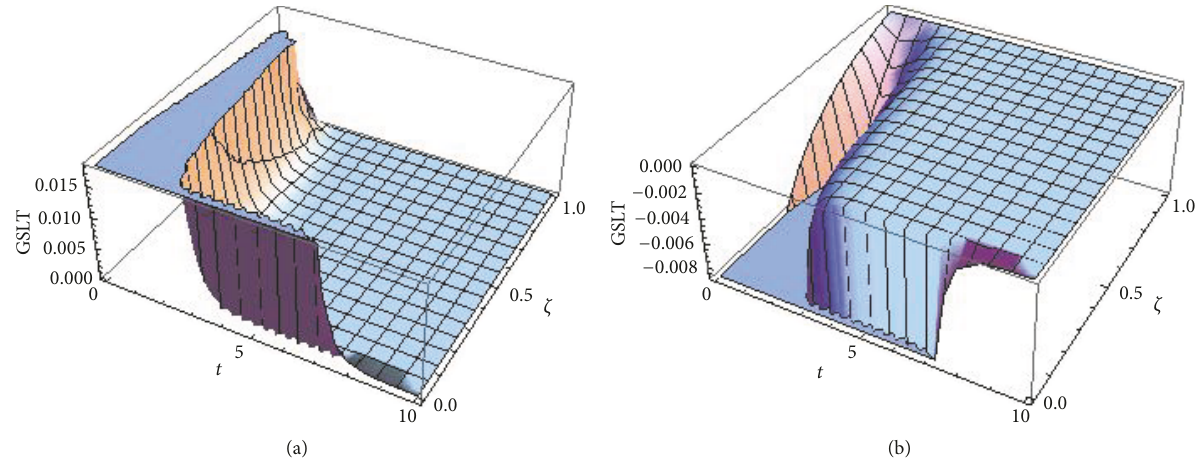
Figure 4: Validity of GSLT for the model (45). (a) is for 𝑐 1 = −1 with 𝑐 2 = 1 and (b) for 𝑐 1 = 𝑐 2 = −1